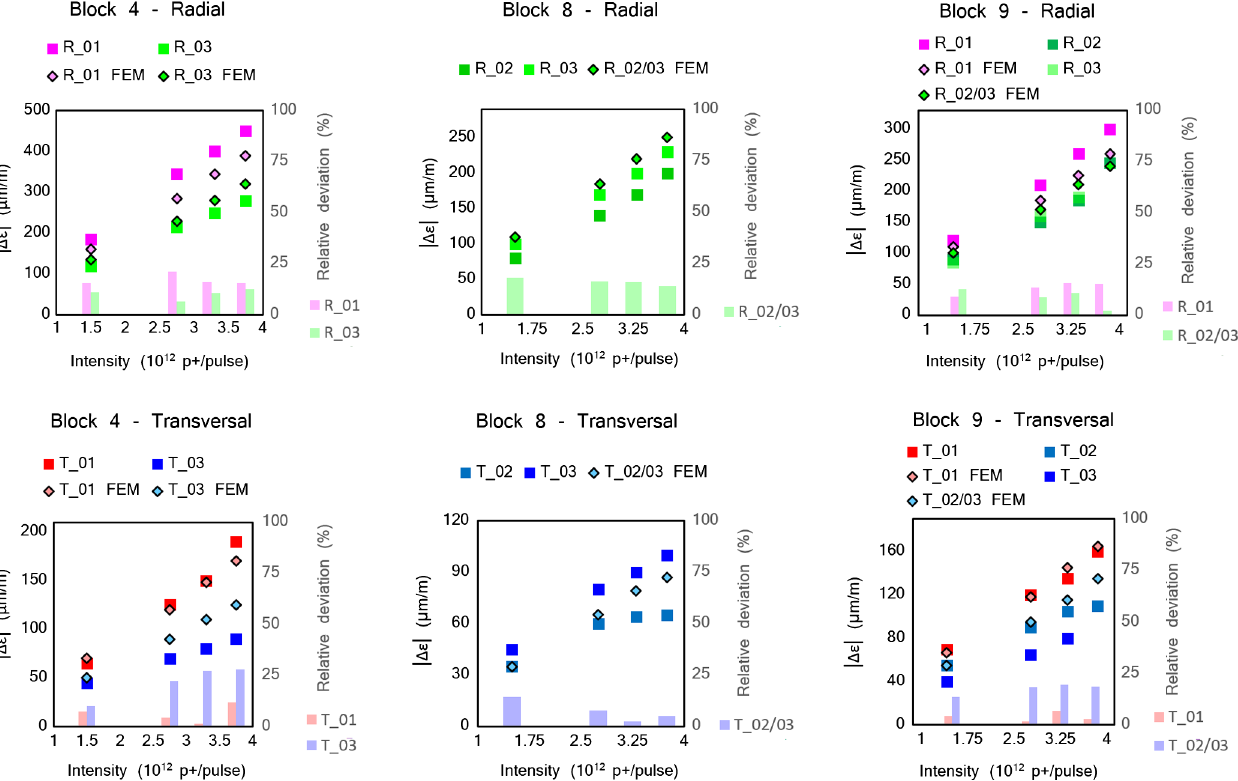
FIG. 19. Strain variation measured in three of the instrumented blocks, in the transversal (T) and radial (R) directions for positions 01 (down), 02 (up left) and 03 (up right), see Fig. 12. The values represented correspond to the average value of strain variation ( j Δ ε j ) measured at different intensities once steady-state regime was reached: 1.5, 2.75, 3 . 25 × 10 12 ppp (10.8 seconds cycle) and 3 . 75 × 10 12 ppp (7.2 seconds cycle). A comparison with the strain variation obtained from the FEM simulations is shown, as well as the relative deviation between the measured and calculated values. Note that the measurements of some of the gauges have not been plotted due to the lack of